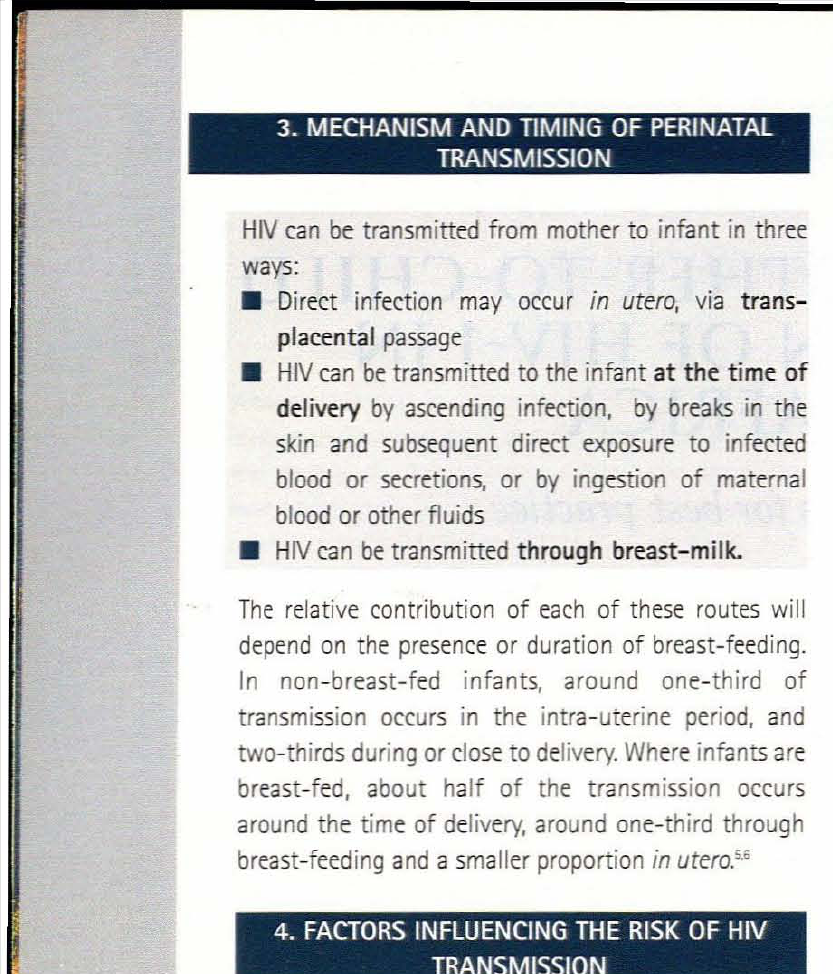
TABLE I. RISK FACTORS ASSOCIATED WITH INCREASED OVERAU RISK OF MOTHER-TO-CHILD